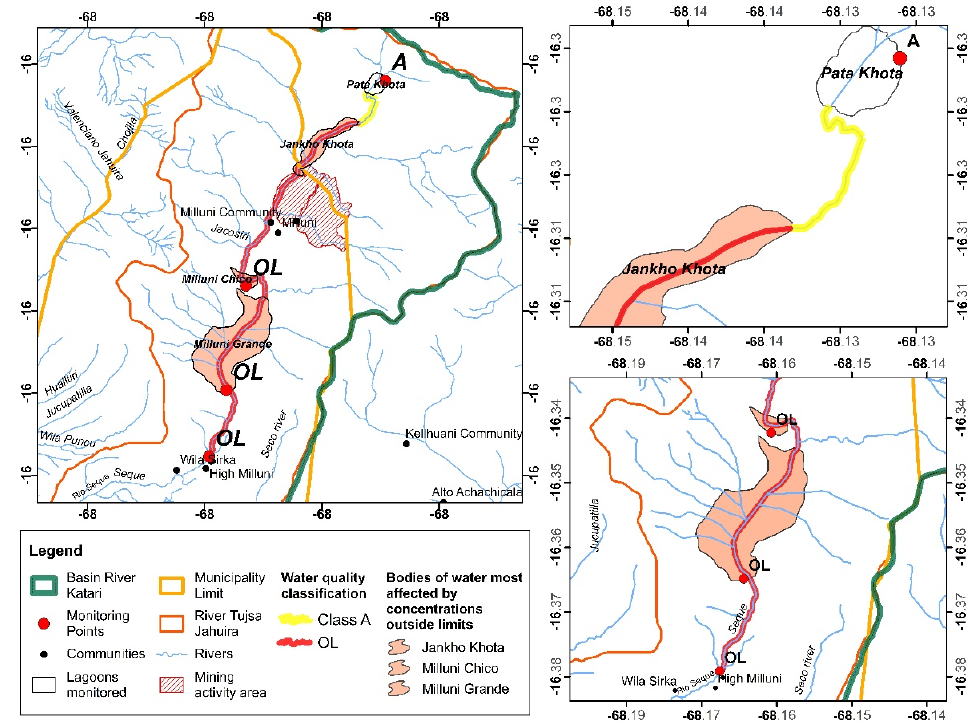
Figure 12. Vulnerable areas to the concentration of heavy metals in Milluni.